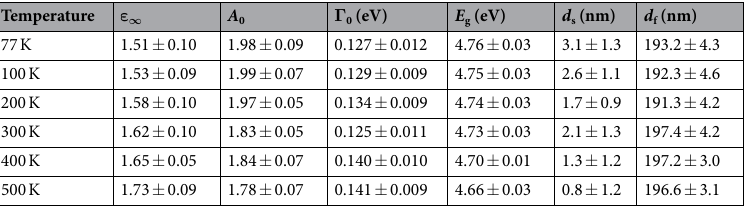
Table 1. The parameter values of the Adachi dielectric function model for KN-Pt determined from the simulation of ellipsometric spectra in Fig. 6a,b. Note that the 95% reliability of the fitting parameters is given with ( ±